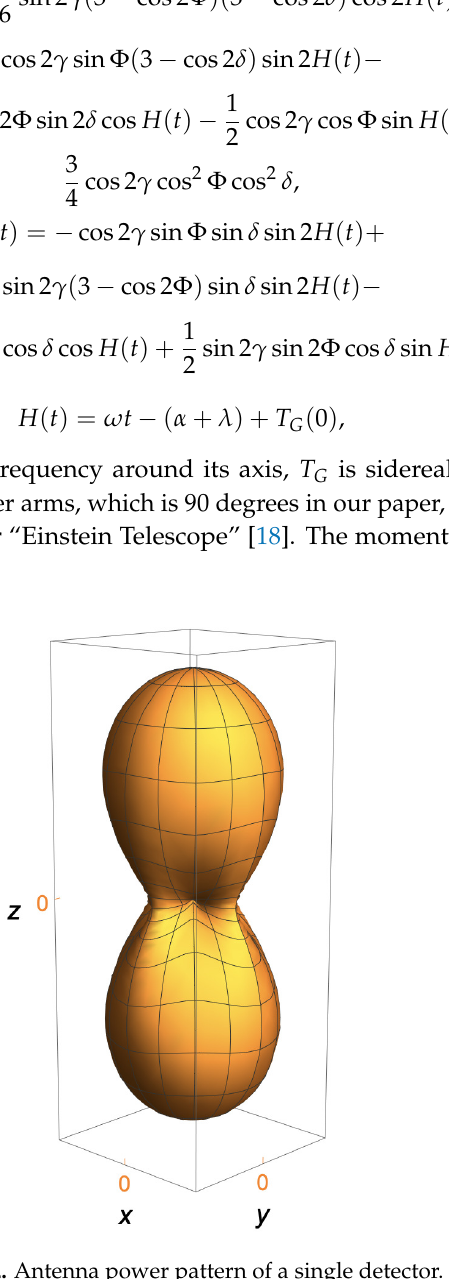
Figure 2. Antenna power pattern of a single